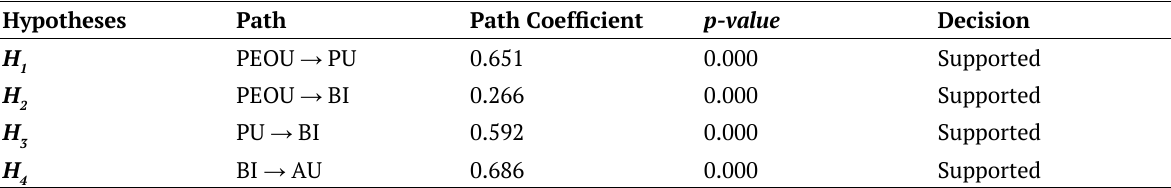
Table 8. Hypotheses testing